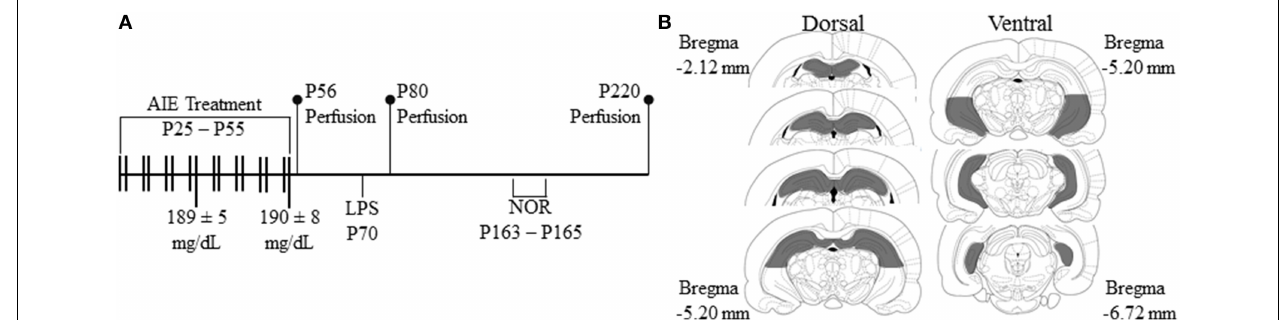
FIGURE 1 | Graphical representation of the adolescent intermittent ethanol (AIE) exposure protocol and experimental design. (A) Rats were treated with either ethanol (5.0g/kg, 20% ethanol w/v, i.g.) or a comparable volume of water on a 2-day on/2-day off administration schedule from postnatal day (P) 25 to P55. Blood ethanol concentrations (BECs) were assessed 1h after ethanol exposure on P38 and P54 (mg/dL). Late adolescent rats were sacrificed on P56 (24h post-AIE treatment). Subjects in the early adulthood group were sacrificed on P80 (25 days post-AIE